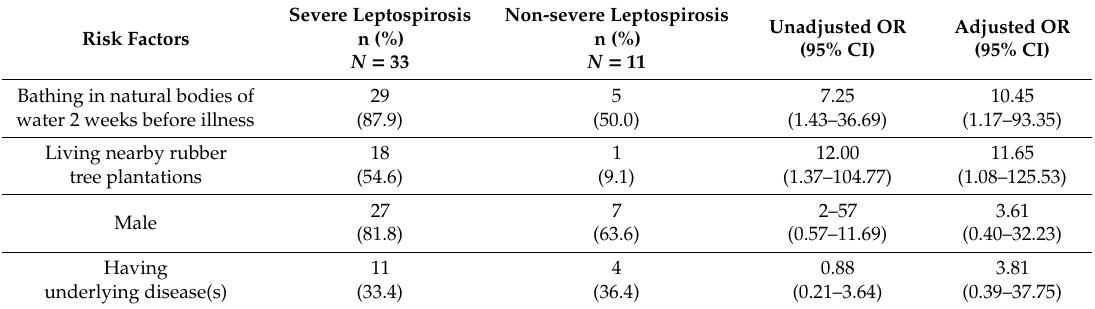
Table 4. Unadjusted and adjusted odds ratios and 95% confidence intervals risk factors for